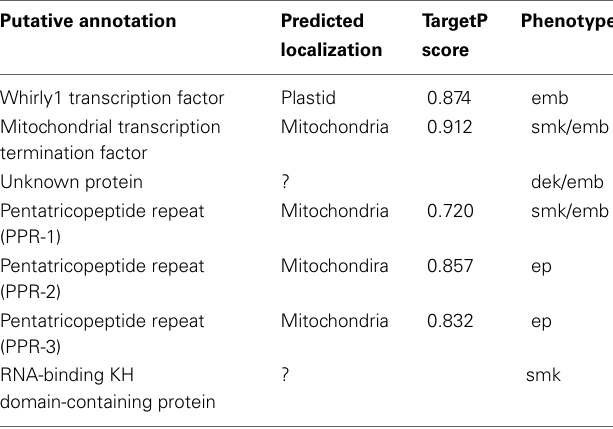
Signal-peptide analysis for the seven, putative, causal genes for seed pheno- types were examined using the web-based TargetP utility. Scores represent con- fidence of the predicted localization. Values over 0.7 were considered strongly predictive. A “?” indicates no localization prediction obtained. Phenotype abbre- viations: embryo lethal (emb), small kernel (smk), defective kernel (dek), empty pericarp (ep).